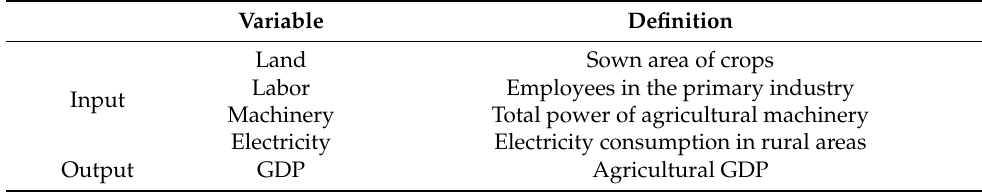
Table 2. Agricultural space utilization efficiency index system.